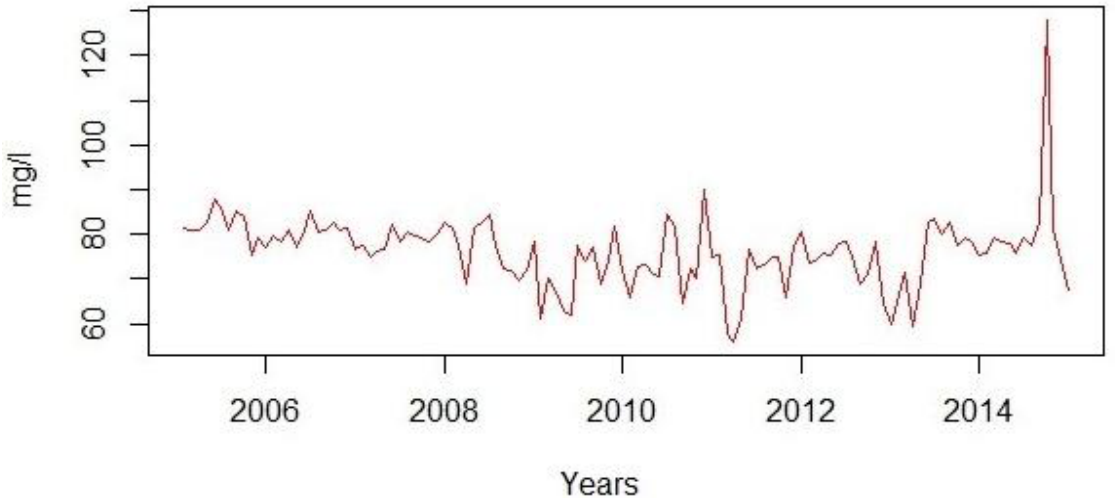
Fig. 2. Concentration of chlorides in the U-3 borehole in the period of January 2005 to January